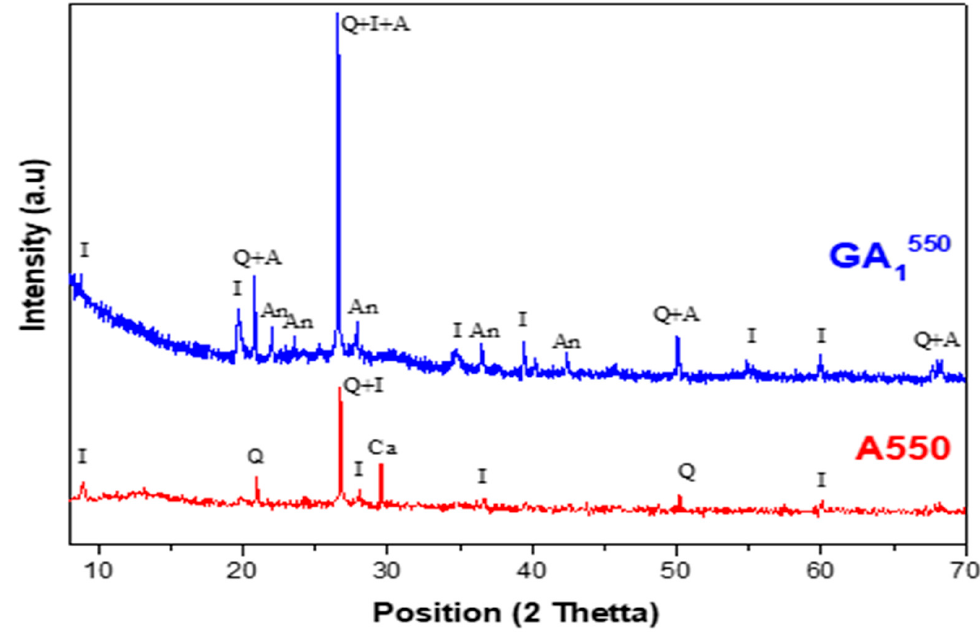
Figure 8. Diffractograms of the GA 1550 aged 7 days and A550 clay with Q—Quartz (01-082-0511), I—Illite (00-026-0911), Ca—Calcite (00-002-0629), A—Aluminum phosphate (01-084-0853), An—Anorthite (00-012-0301) .